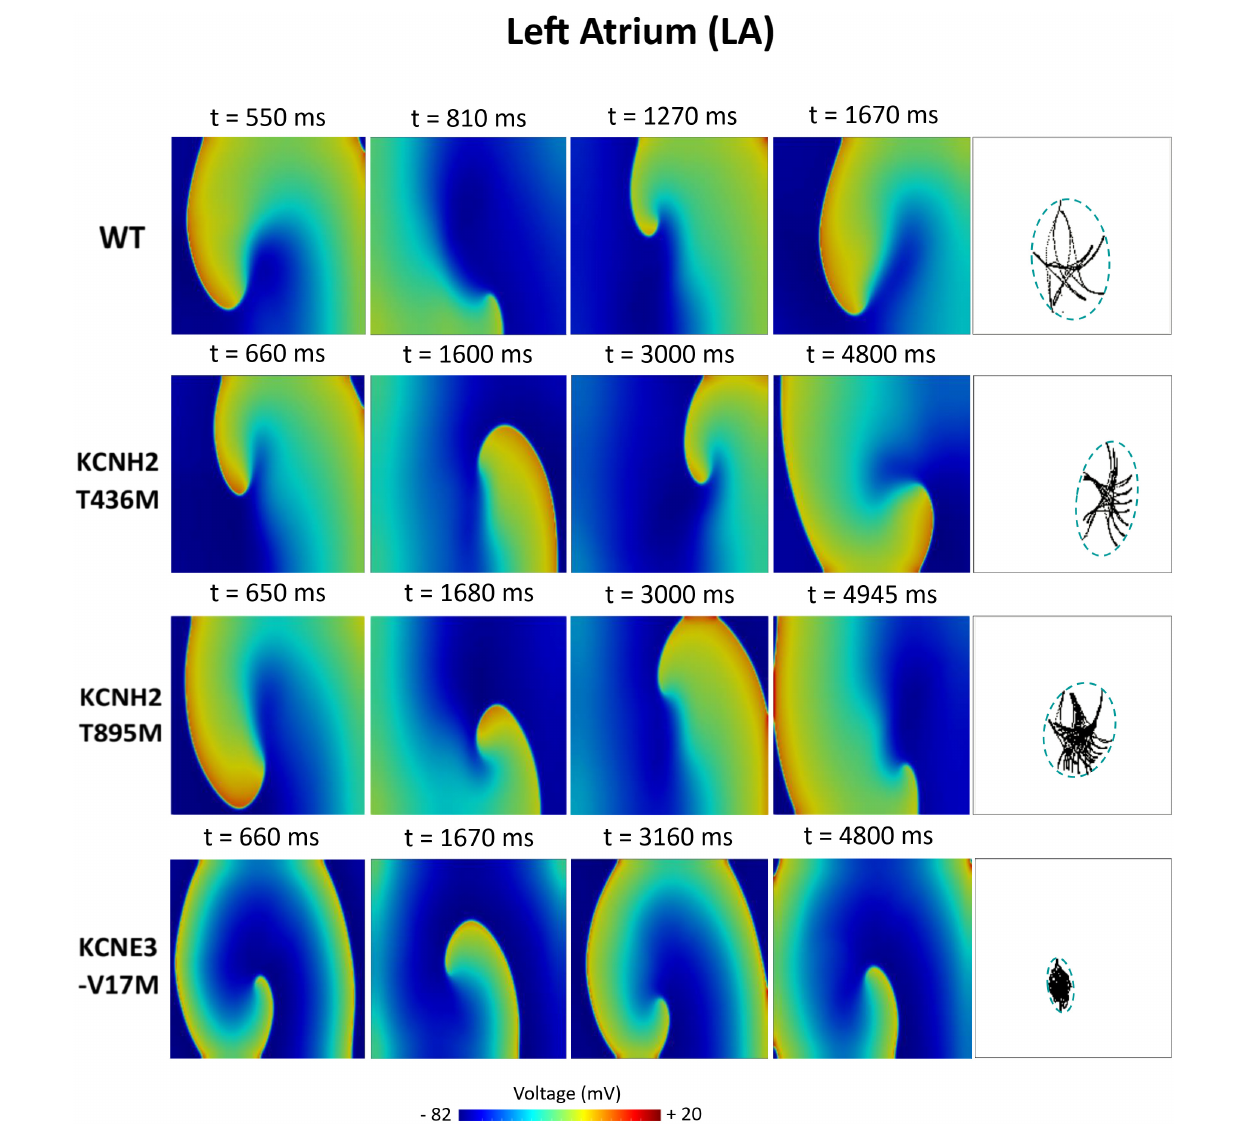
FIGURE 7 | Simulation of spiral waves in 2D left atrium in control (WT) and affected by KCNH2 T436M, KCNH2 T895M, and KCNE3-V17M mutations. Color-coded voltage snapshots of the rotors and rotors’ tip trajectory enclosed by an ellipse for the quantification of the meandering rotor’s area. S1–S2 interval for WT model was 223